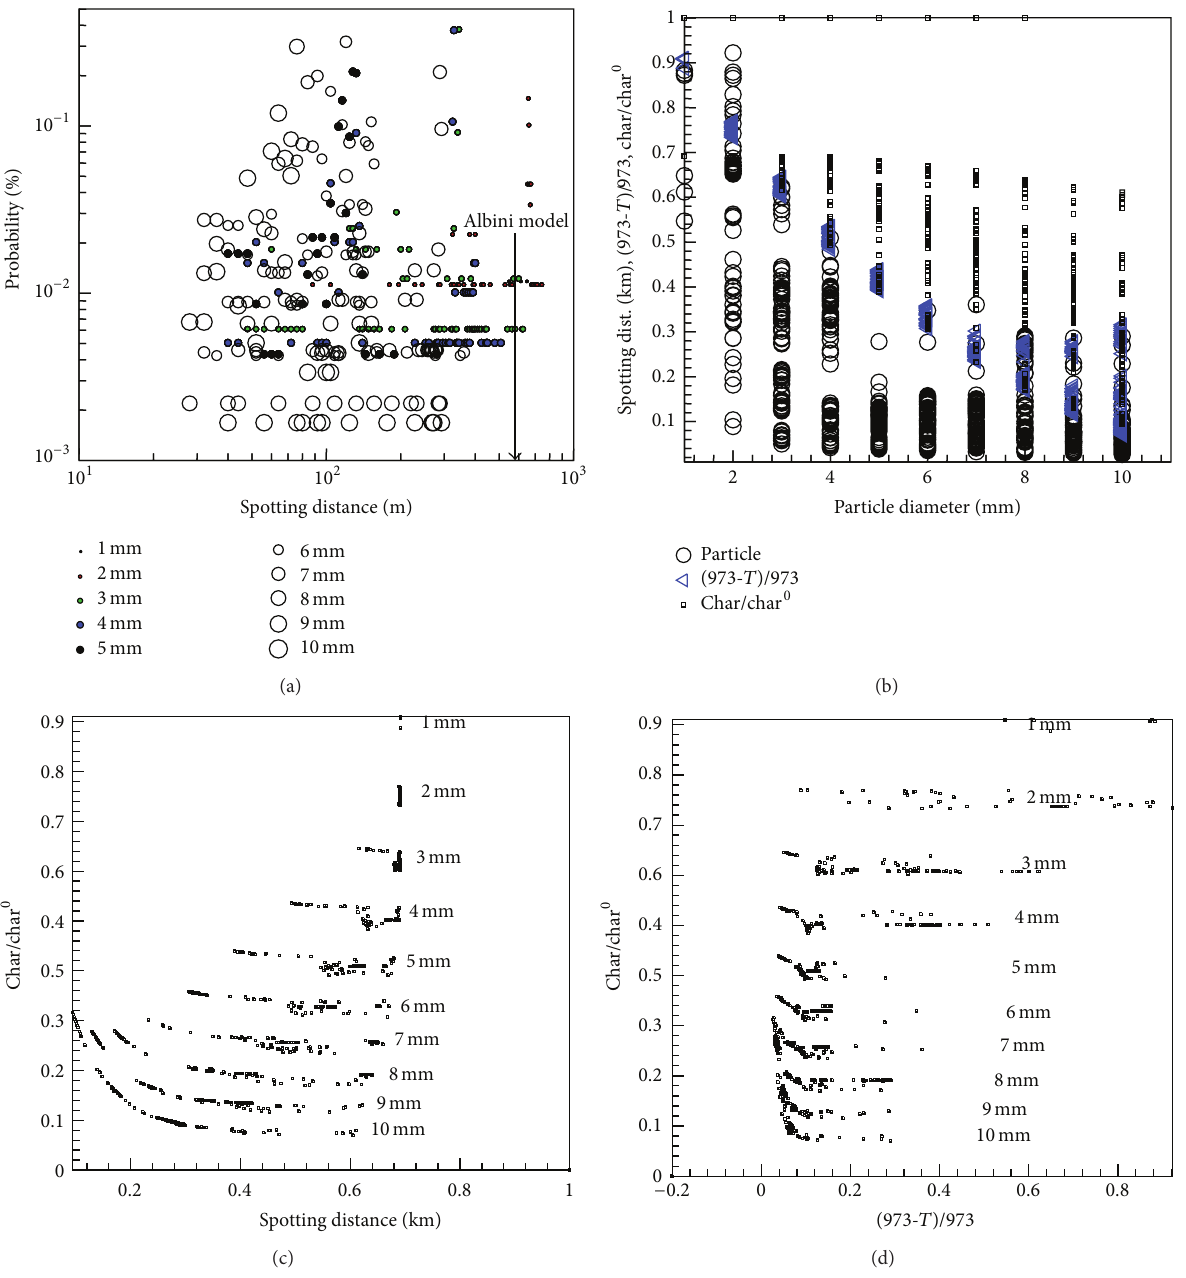
Figure 8: Single torching tree results: (a) spotting distance; (b) char, temperature, and spotting distance as a function of particle size; (c) char as a function of particle spotting distance; and (d) particle char as a function of particle